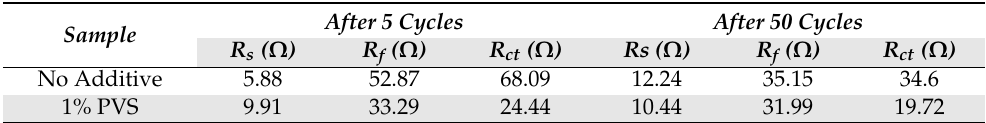
Table 2. Data obtained from the fitting EIS diagrams of the electrodes cycled in the electrolytes without and with 1 wt % of PVS after 5 cycles at 0.5 C and 50 cycles at 1 C.